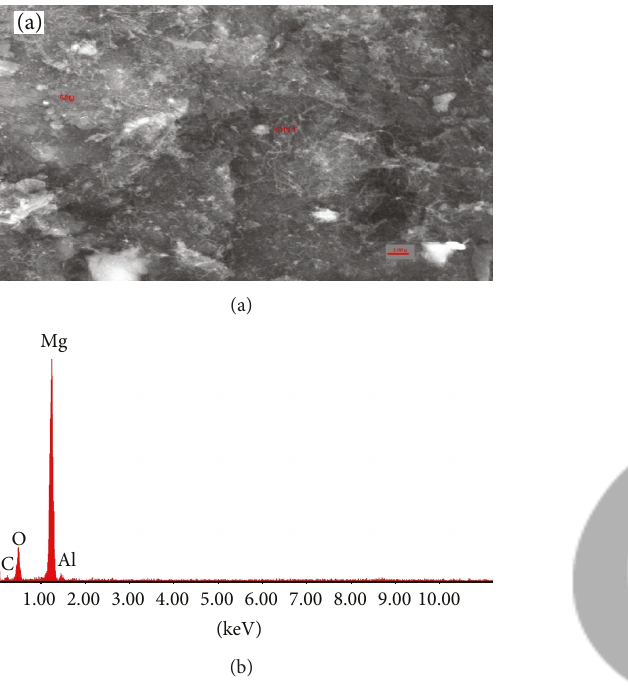
Figure 2: SEM and EDS image of AZ31-0.66wt% CNT composite sample. Figure 3: SEM and EDS image of AZ31-1wt% CNT composite